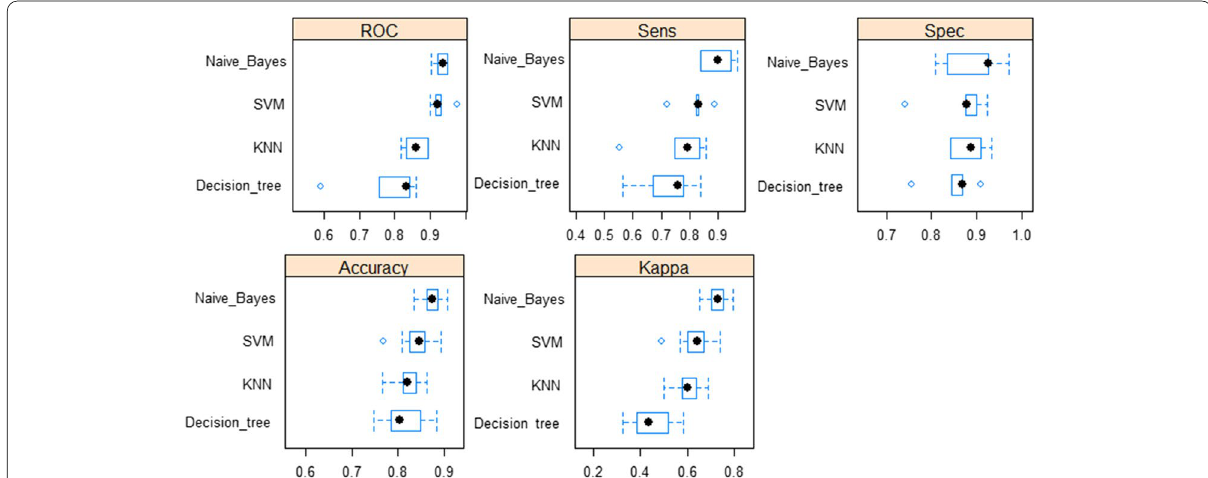
Fig. 6 Comparative analysis of the four machine learning algorithms across sensitivity analysis statistics for the training set. ROC Curve, Sens Sensitivity score and Spec Specificity = =